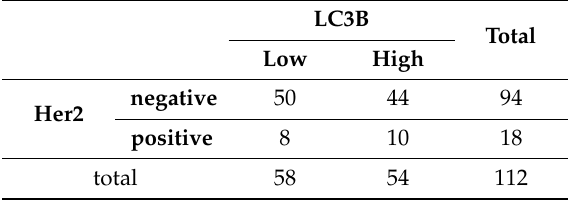
Table 1. Results of the LC3B scoring in correlation with the Her2 Table 1 . Results of the LC3B scoring in correlation with the Her2 status.